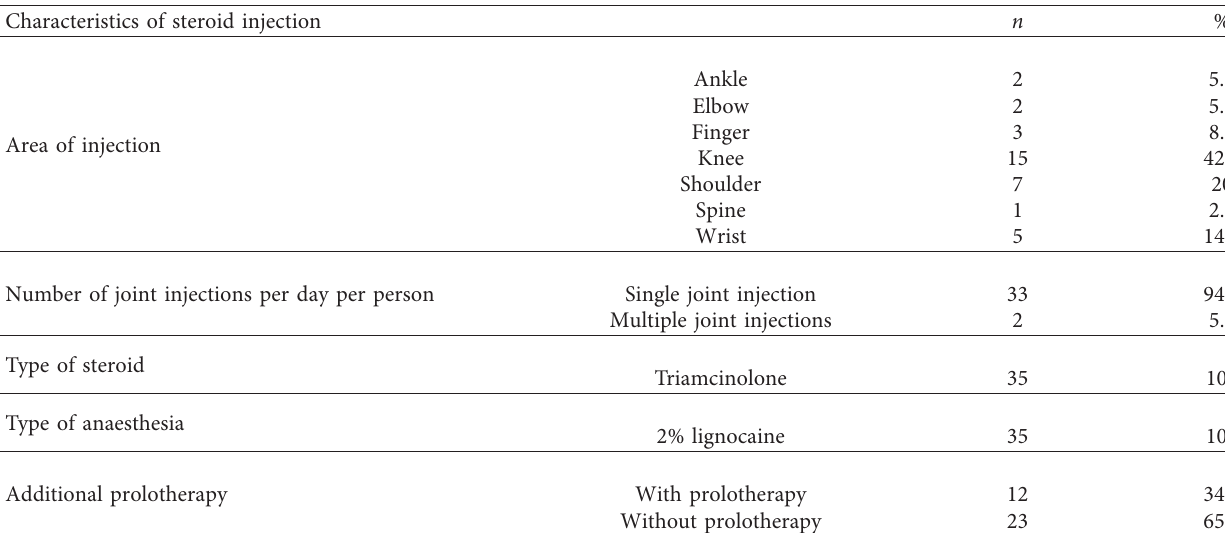
Table 2: Characteristics of musculoskeletal steroid injections.